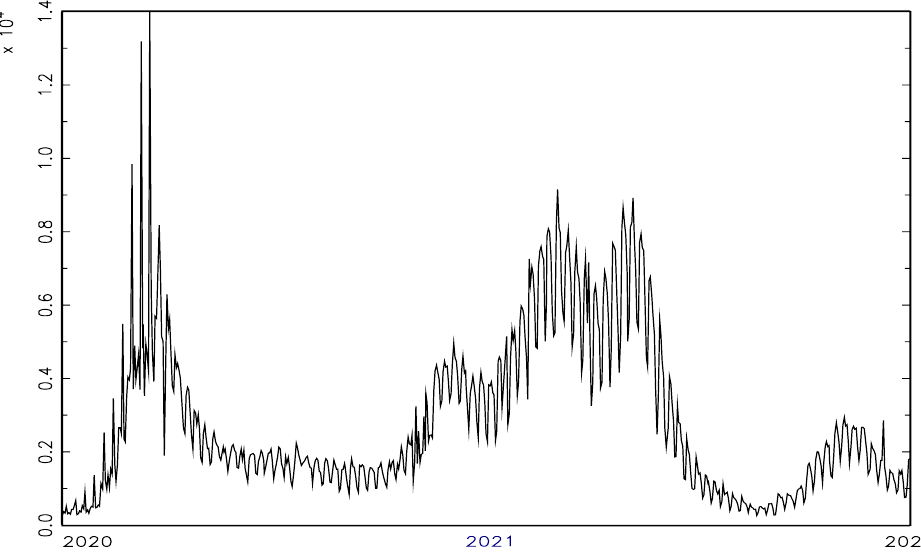
Figure 1. New cases of infection with COVID-19 in Chile (1 April 2020 to 31 December